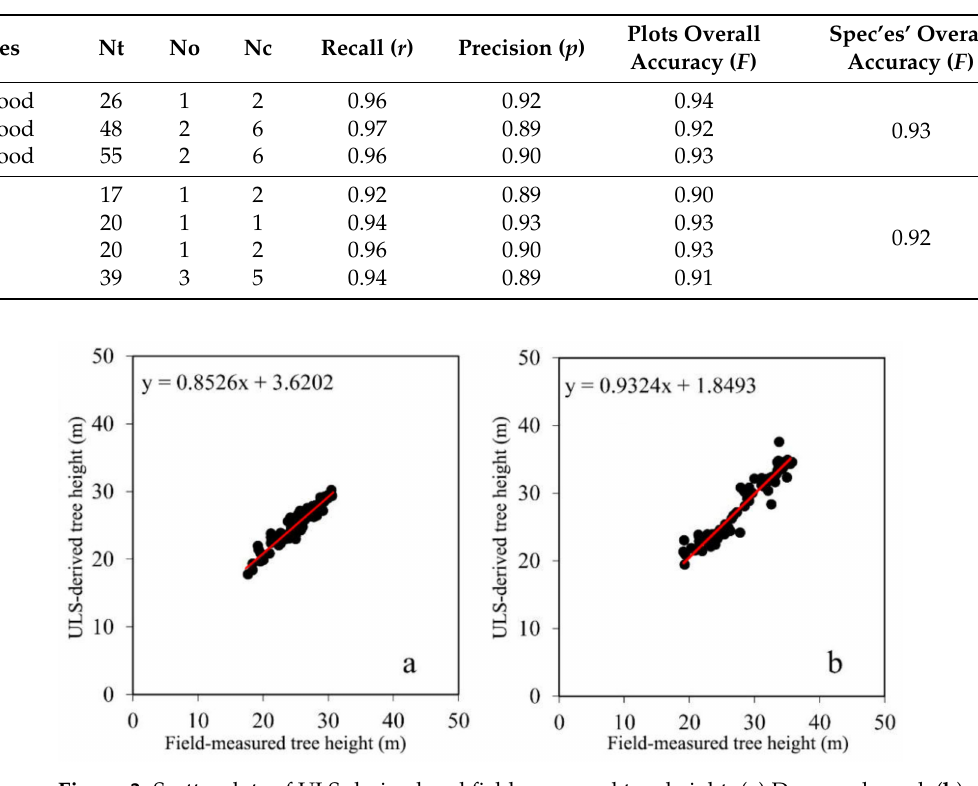
Table 3. Assessment of the accuracy of BLS point cloud data segmentation. Nt: the number of treetops detected that existed in the field position; No: the number of trees that were omitted by the algorithm; Nc: the number of detected trees that did not exist in the field; r : detection rate; p : the precision of the detected trees; F : overall accuracy.